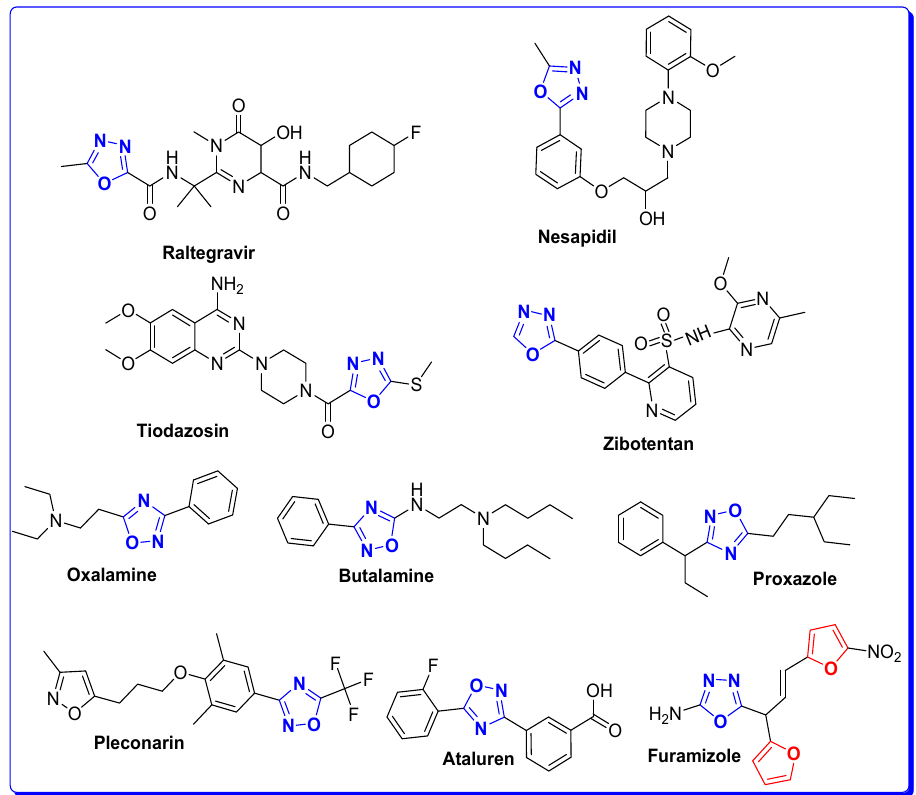
Figure 1. The most famous oxadiazole core-based clinical drugs.